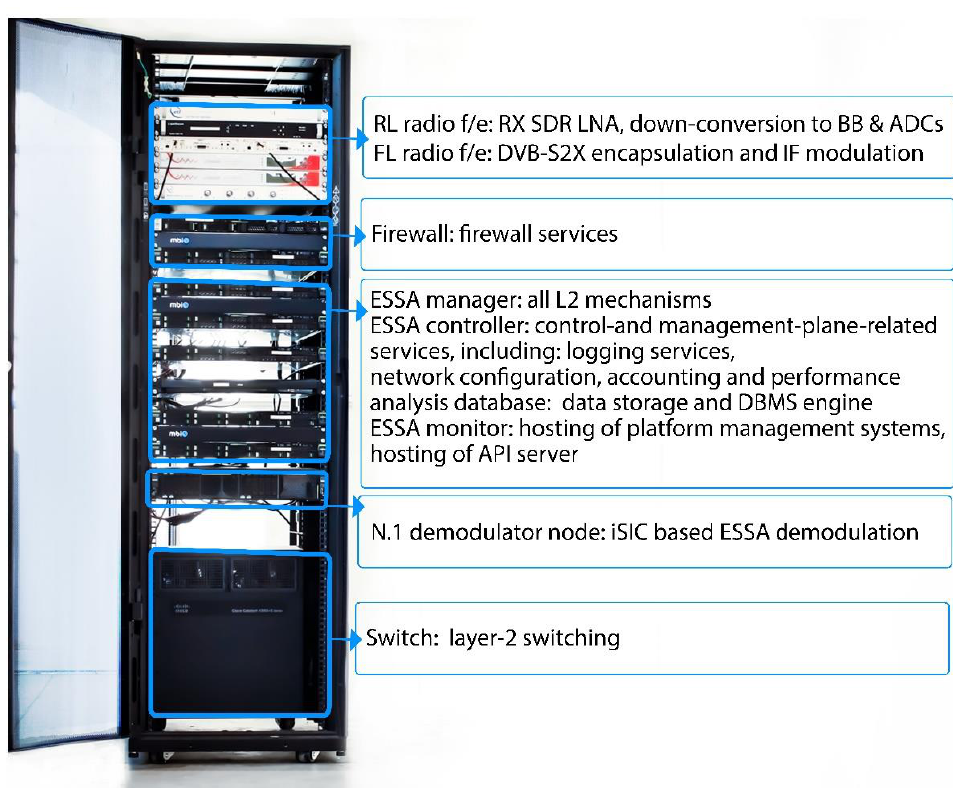
Figure 12. HyperCube platform hosted in a 19 ″ rack.